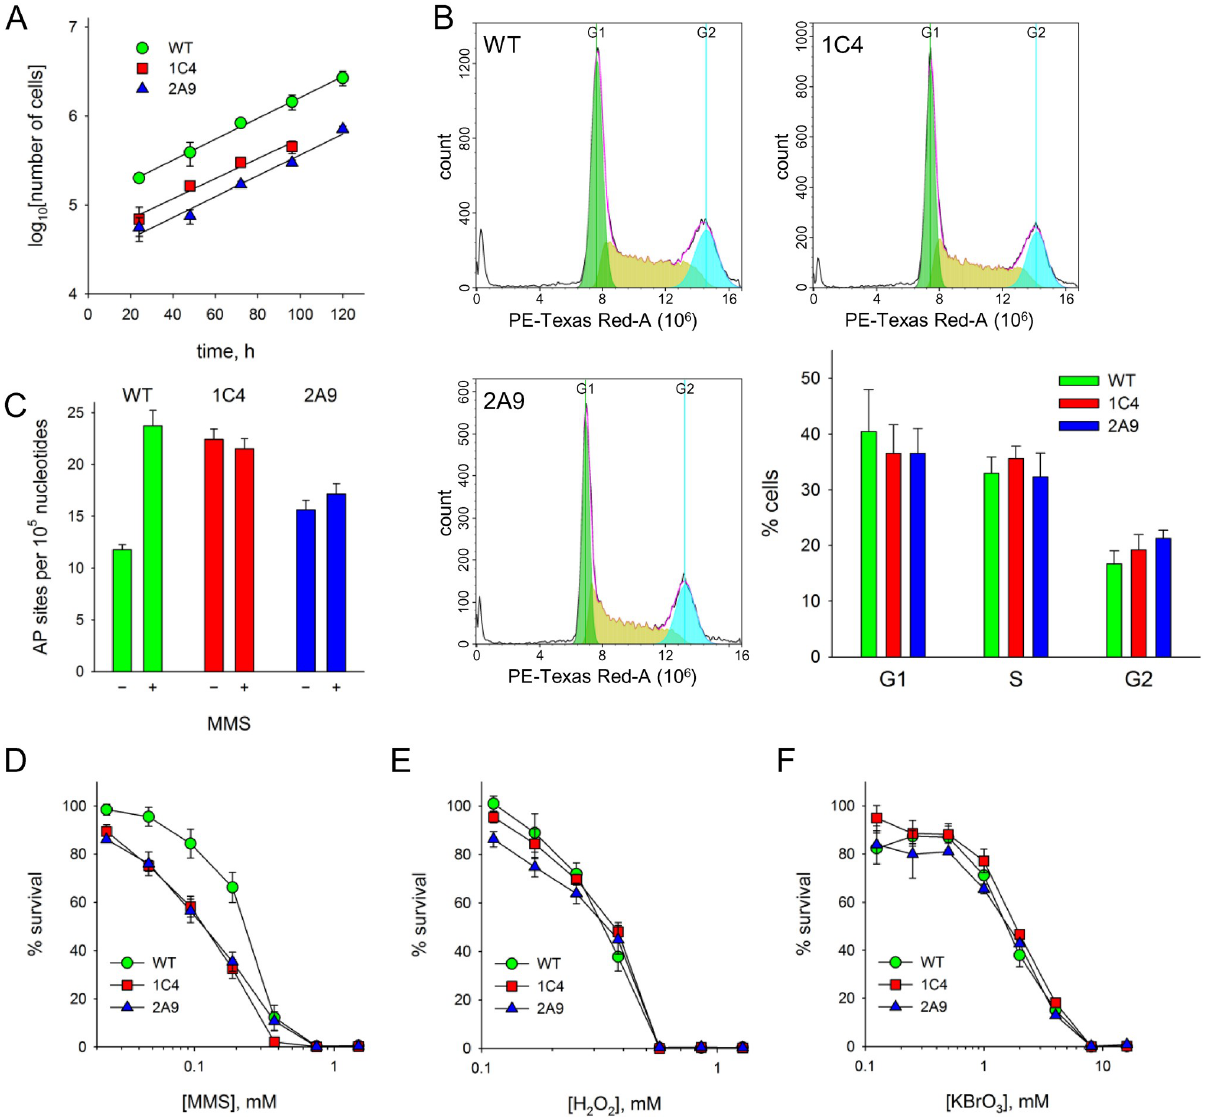
Fig 3. Phenotypic consequences of the APEX1 knockout. A, growth curves of wild-type HEK 293 ( circles ) and knockout cells 1C4 ( squares ) and 2A9 ( triangles ). Mean ± s.d. is shown ( n = 2). B, cell cycle analysis of wild-type and knockout cells using propidium iodide staining. Representative cell count histograms and percentage of cells in G1, S and G2 phases in a non-synchronized population ( n = 3, mean ± s.d.) are shown. C, accumulation of AP sites in wild-type HEK 293 ( green ) and knockout cells 1C4 ( red ) and 2A9 ( blue ) with and without MMS treatment. Mean ± s.d. is shown ( n = 2). D–F, sensitivity of wild-type HEK 293 and knockout 1C4 and 2A9 cells to MMS ( Panel D , n = 4), H 2 O 2 ( Panel E , n = 3) and KBrO 3 ( Panel F , n = 3). Cell line symbols are as in Panel A . Mean ± s.d. is shown.